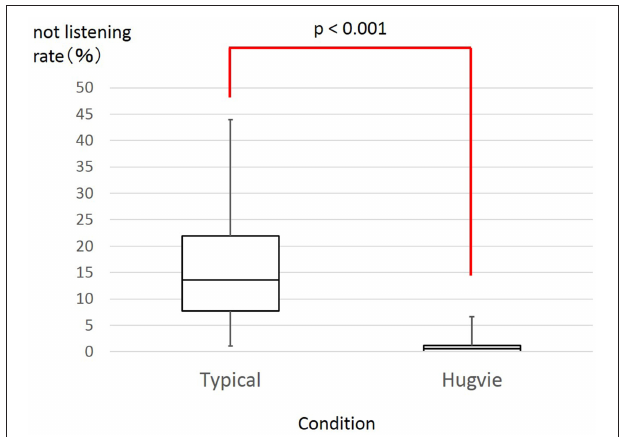
FIGURE 3 | Rate of children who directed their faces at something other than volunteers.